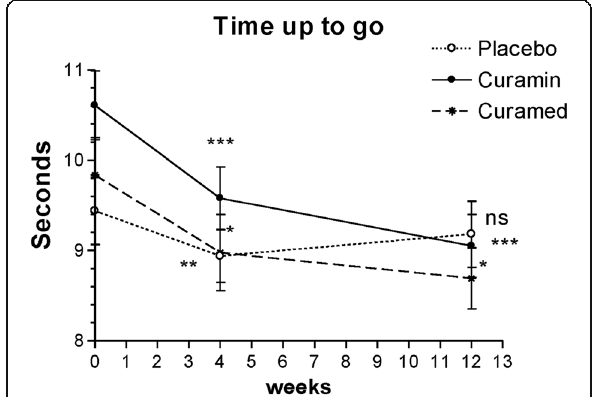
Fig. 4 The changes with time in the time required to rise from a chair, walk 3 m, turn, and walk back to the chair at weeks 0, 4, and 12 in the Curamin, CuraMedand placebo treatment groups. Within-group improvements (* p <0.05, ** p <0.01, *** p <0.001) in physical performance